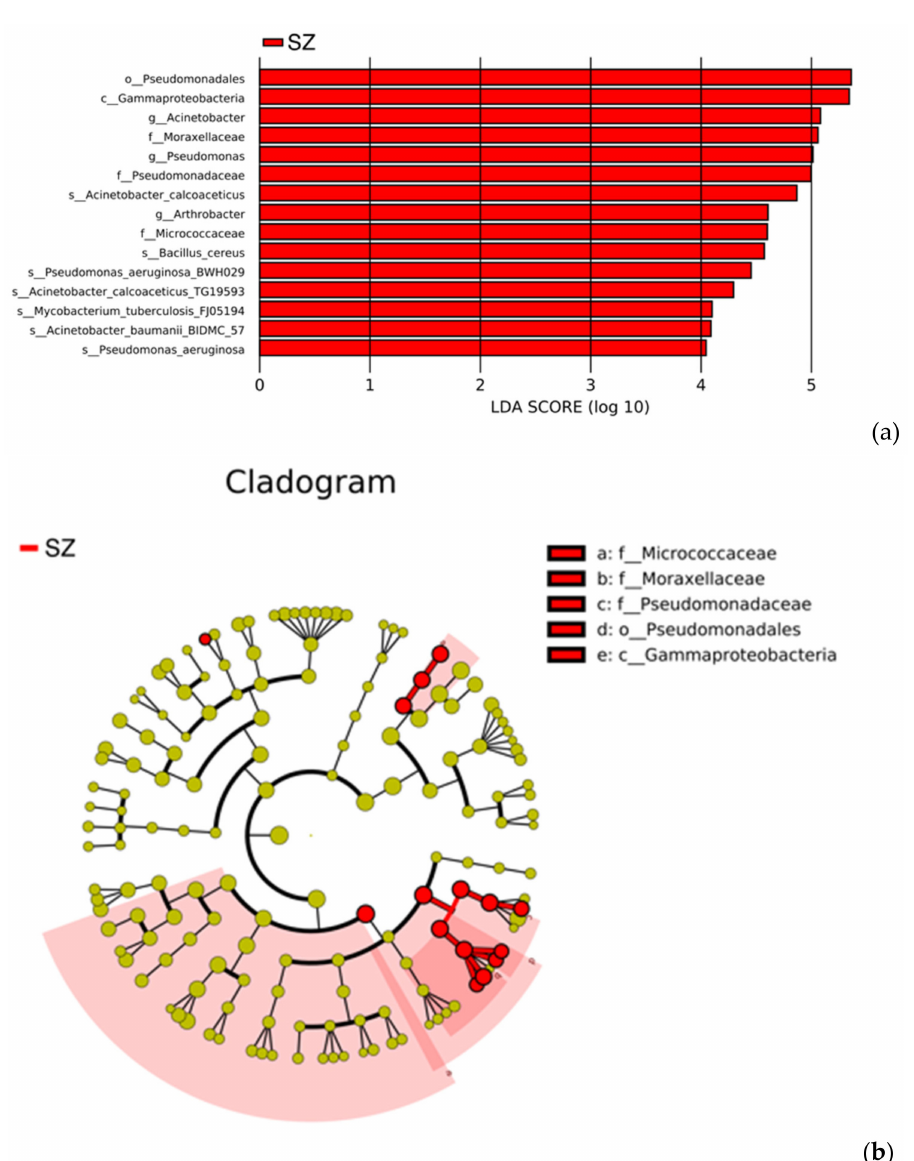
Figure 8. LDA score diagram and cladograms by LEfSe: ( a ) The distribution of LDA score for differential HPB species (LDA > 4). Red bars represent the more abundant HPB species in SZ; ( b ) cladogram for the different HPB species from SZ. Circles radiating from inner to outer represent taxonomic levels from phylum to species. Yellow nodes represent the species without significant differences, and red nodes indicate the microbial taxa that play an essential role in